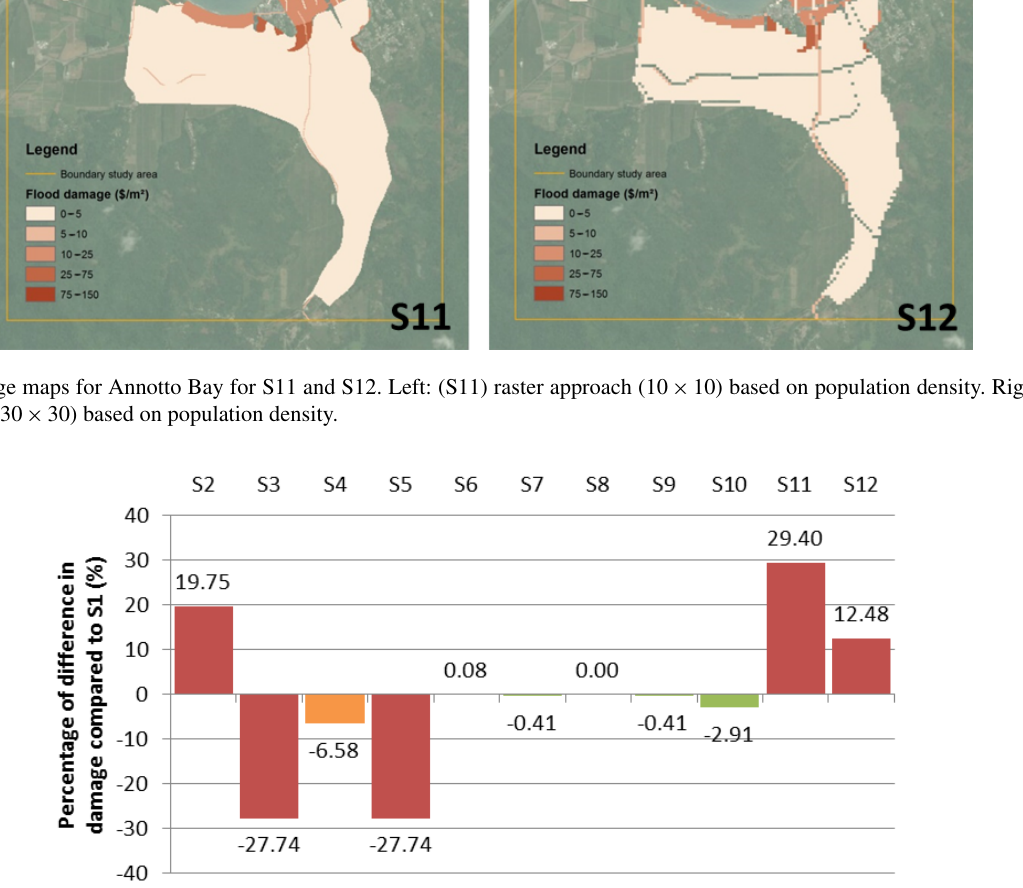
Figure 9. Deviation of total damage of all scenarios in relation to S1 ( =